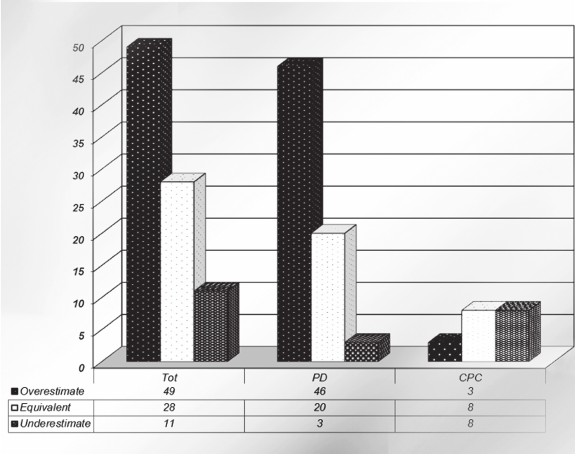
figure 2 - Rates of curvature estimation in the whole cohort, and as segregated for cpc and pD. Overall, most men with pD overestimated their curvature; conversely, men with cpc underestimated or provided a self-assessment of their curvature equivalent to that given by